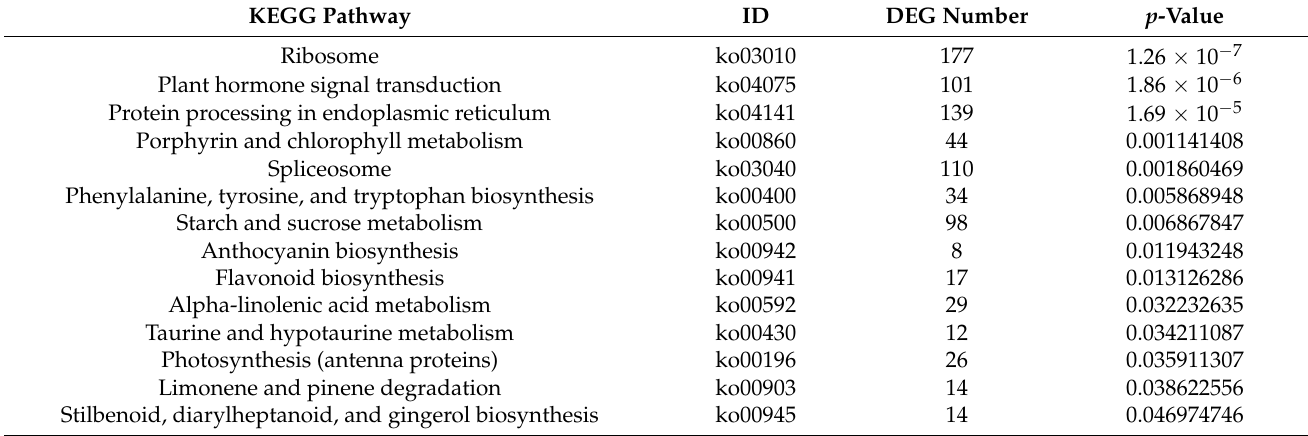
Table 4. Significant enrichment of metabolic pathways in the KEGG database in the drought stress vs. control groups